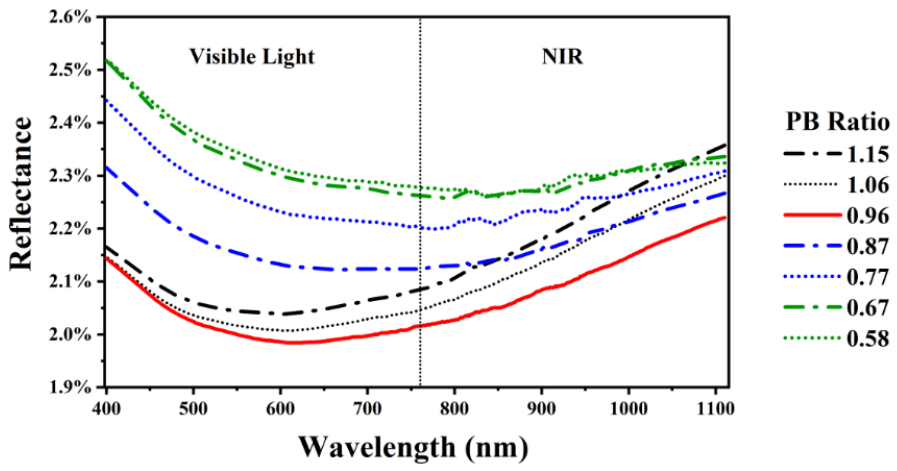
Figure 8. Reflectance of different PB ratio samples. Table 1. Adhesion classification of different PB ratios according to ASTM and ISO standard methods. PB